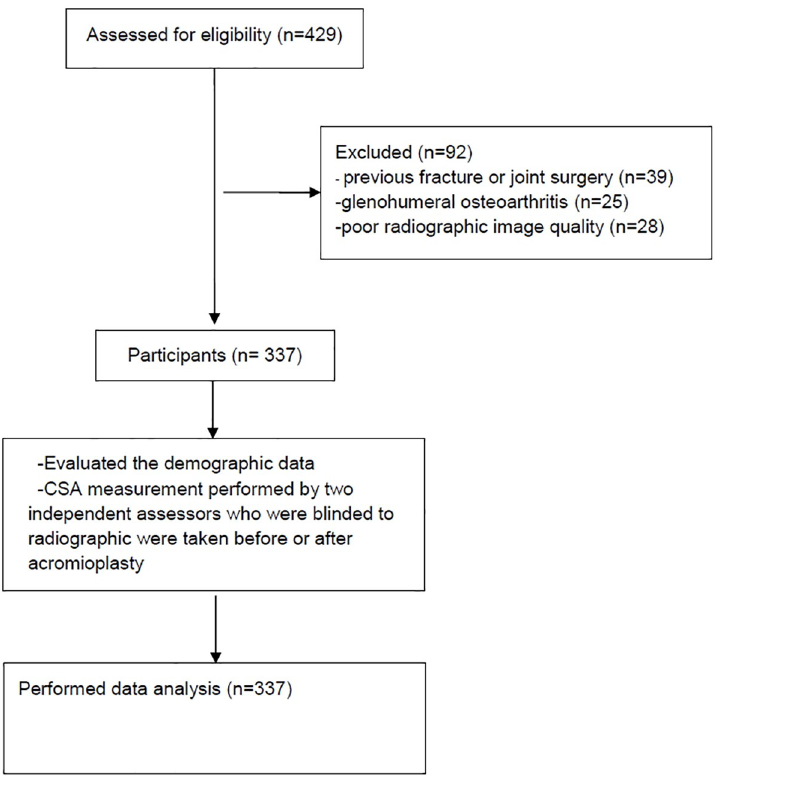
Fig 2. Schematic of the study protocol.